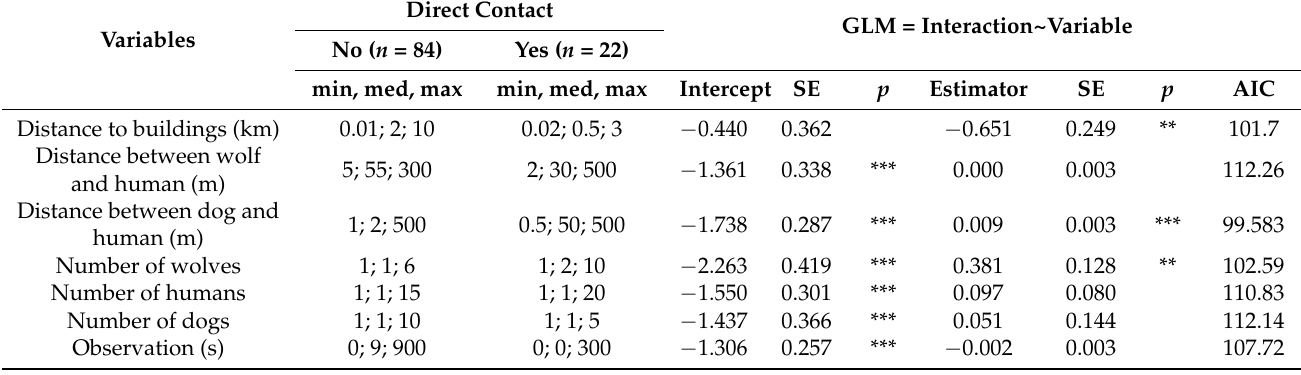
Table 1. Descriptive statistics of continuous variables and GLM (family = binomial) results of parameters estimated to explain occurrences of dog–wolf direct contact (models with one explanatory variable).